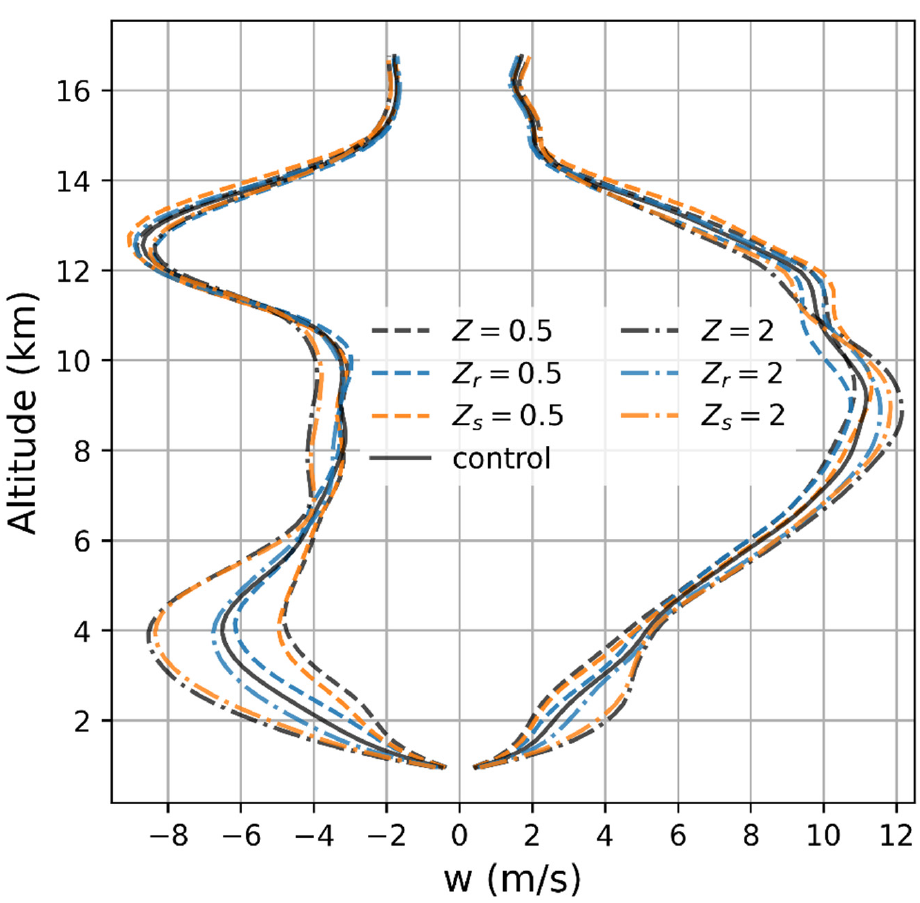
Figure 7. The distribution of the top 99.9 percentile of updrafts/downdrafts averaged in 50–70 min in the entire domain as a function of height. The percentiles of each level are calculated separately at each time step. The data have a temporal spacing of two minutes.